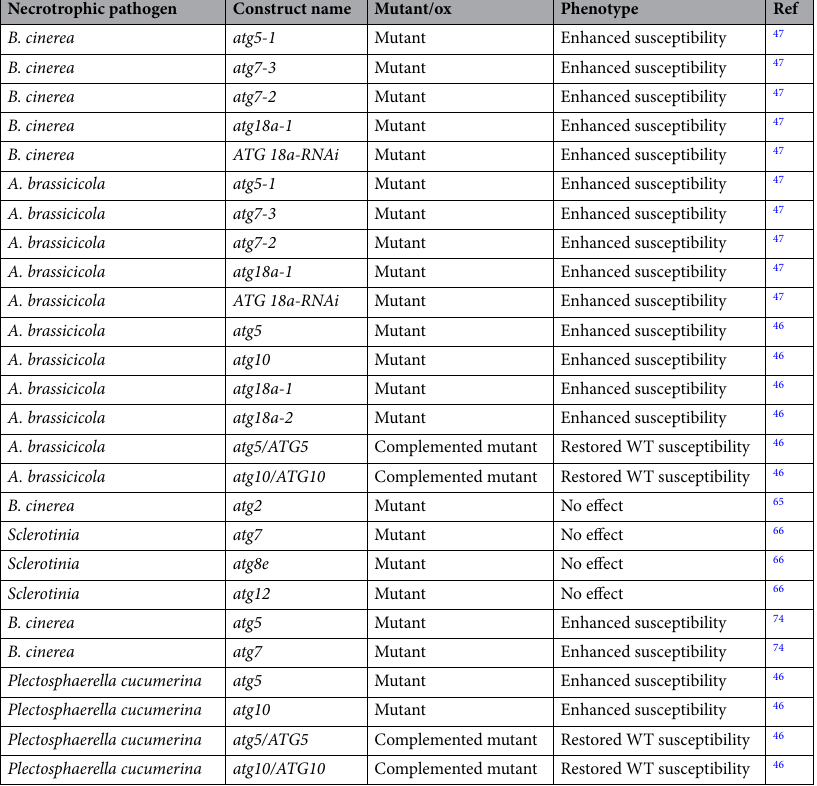
Table 1. List of studies about autophagy involvement in disease cause by necrotrophic fungi on